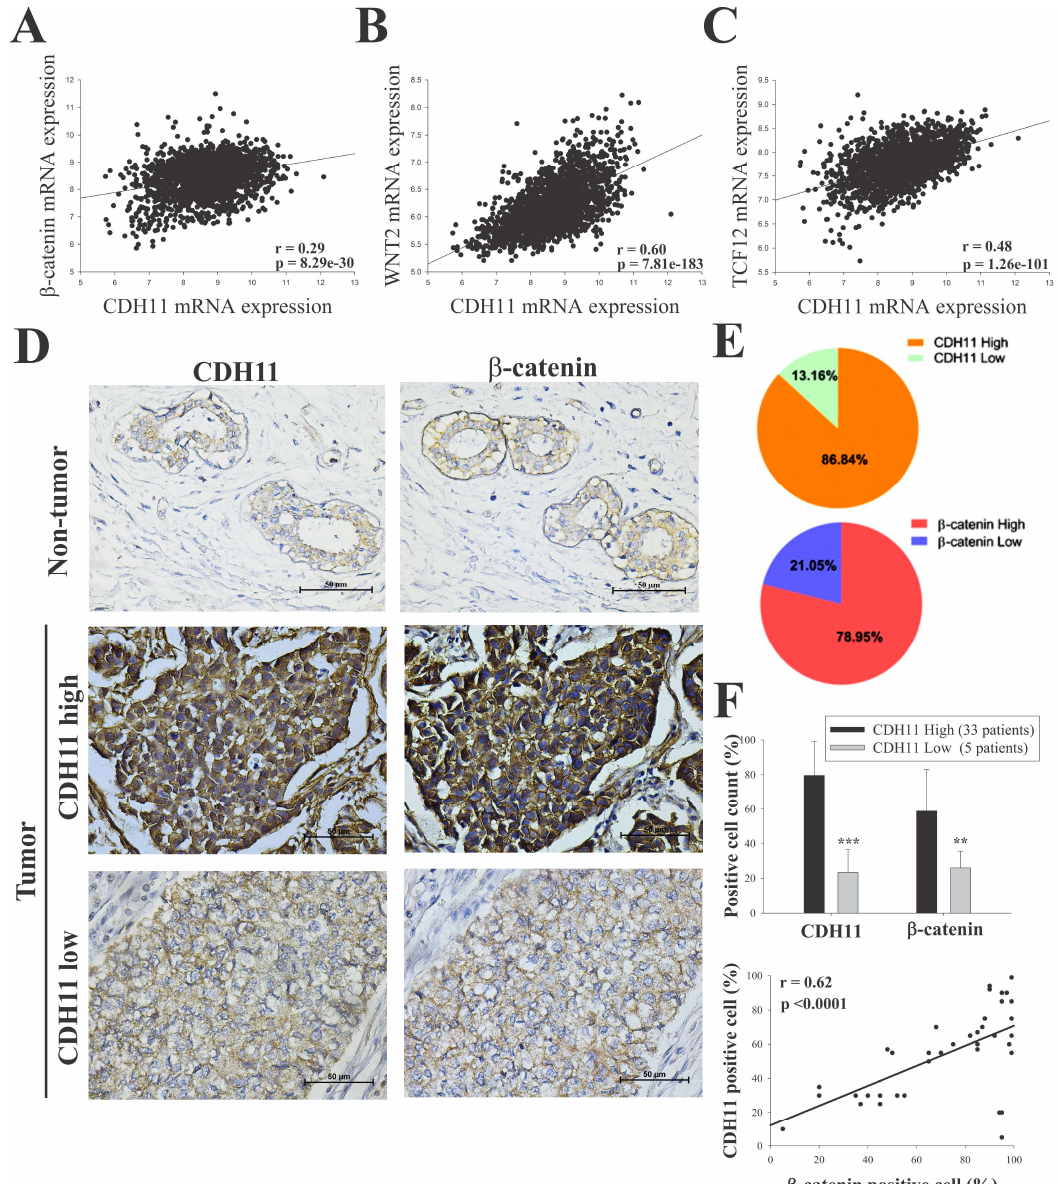
Figure 2. CDH11 positively modulates β -catenin expression and activates the canonical WNT signalling pathway. Statistical analyses of the TNBC sub-group of the METABRIC Breast Cancer cohort ( n = 1904) show positive correlation between expression of CDH11 and ( A ) β -catenin, ( B ) WNT2, and ( C ) TCF12 mRNA. ( D and E ) Differential expression of CDH11 and β -catenin in non-tumor and TNBC tissue samples demonstrated by representative IHC images and percentages of patients. Scale bar: 50 µ m. ( F ) Histogram showing positive correlation between CDH11 and β -catenin protein expression level in our TNBC cohort ( n = 38). * p < 0.05, ** p < 0.01, *** p < 0.001